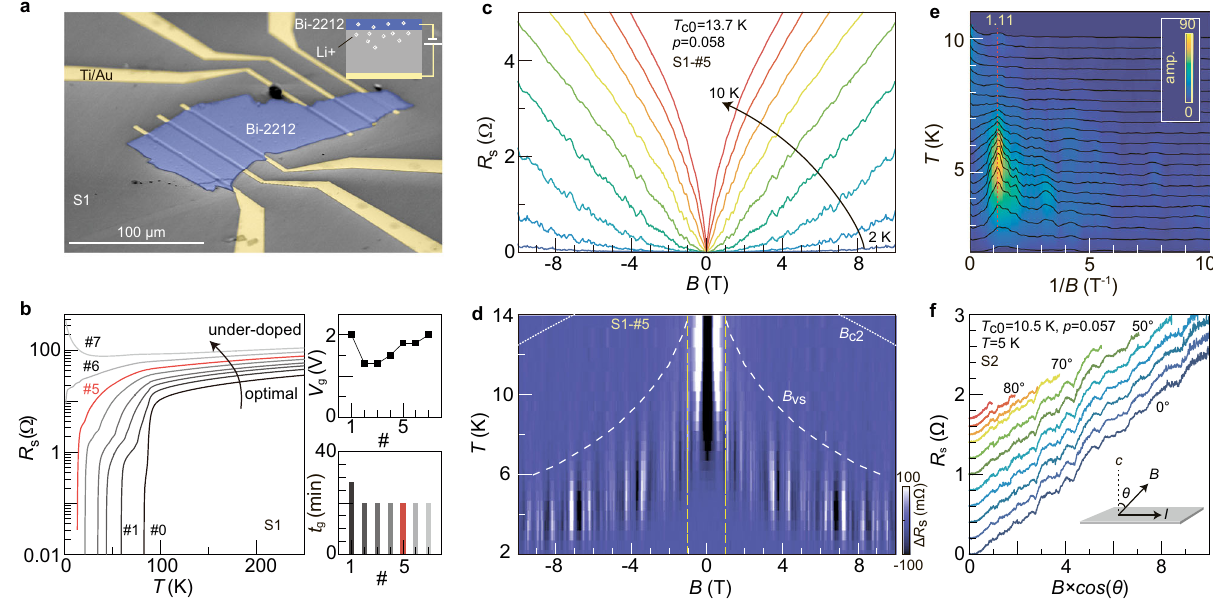
Fig. 1 Resistance oscillations in underdoped Bi-2212. a False-color scanning electron microscopy image of sample S1. The Bi-2212 fl ake (electrode) is highlighted in blue (yellow). The substrate is a solid ion conductor containing lithium ions. The inset illustrates the gating con fi guration. b Main panel: temperature dependent resistances of S1 at sequentially gated states. Right panels: gating voltages ( V g ) and estimated gating time periods ( t g ) for each sequence. t g includes the complete course of gating at three stages: warming up from 280K to 300K; staying at 300K; cooling down from 300K to 280K. V g is applied throughout the above-mentioned course of time. c Sheet resistance of S1 in an underdoped state (S1-#5) as a function of magnetic fi eld at a selected set of temperatures (from 2 to 10K in steps of 1K). We estimate the doping level p by using the experimentally measure d T c0 and the formula: (cid:5) (cid:6) T c 0 ¼ T c ; max 1 (cid:2) 82 : 6 p (cid:2) 0 : 16 ð Þ 2 . d Color plot of the background subtracted resistance 4 R of S1-#5. Bright and dark stripes in the magnetic fi eld range from − 1 to 1T (dashed vertical lines) are artefacts from over-smoothening. Data outside this region is not affected. White dashed curve indicates the line where the resistance reaches 10% of the normal state resistance (zero- fi eld resistance value at 87K). It represents the phase boundary between the vortex solid (vs) and the vortex liquid. White dotted curve is a guide to the eye, illustrating th e expected temperature dependence of the upper critical fi elds. e Fast Fourier transform (FFT) of the resistance traces at different temperatures in d . The dotted line with the number marks the peak position in FFT. f Angular dependent study of the magneto-resistance of S2 as a function of the perpendicular magnetic fi eld. The angle θ is between the total magnetic fi eld and the normal to the sample plane (inset). It increases from 0° to 70° in steps of 10° and from 75° to 85° in steps of 5°. Curves are vertically offset for clarity. evolution of resistance oscillations. Figure 2 shows data sets of sample S3. We select the representative results at 6 doping levels out of the total 10 superconducting states we realized. They are arranged from left to right with decreasing p , which follows the gating sequence. Figure 2a shows the color-coded magneto- resistance. In each panel, the purple areas represent the normal state and the dark blue regions indicate the superconducting regime. The white color corresponds to the resistance value that is half of the normal state resistance, indicating the superconducting transition region. Figure 2b shows the background subtracted data Δ R B ; T ð Þ . The zebra stripes are prominent in Fig. 2b2 – b6 ( p ≤ 0 : 084) but are missing in Fig. 2b1 ( p ¼ 0 : 1). These stripes always appear in the superconducting transition region (slightly below the white bands in fi gures of the top row of Fig. 2), reaf- fi rming their intimate link to superconductivity. The oscillation amplitude increases monotonically with decreasing doping as indicated by the increasing scales of the color bars. In Fig. 2c, we show the FFT results at different doping levels. The vertical dotted lines mark the peak positions, which seem to show little doping dependence. Their values are consistent with that obtained in sample S1. In Fig. 3, we summarize the experimen- tally investigated temperature points and doping levels for fi ve samples. We use fi lled symbols to indicate that resistance oscil- lations (RO), such as those shown in Fig. 1c, d, f and Fig. 2b2 – b6, are experimentally observed. The fi lled points cluster in the lightly doped regime ( p ≤ 0 : 08) of the superconducting dome. It indicates that RO are reproducible across different samples, as long as the samples are tuned into the extremely underdoped regime. NATURE COMMUNICATIONS| (2022) 13:1316